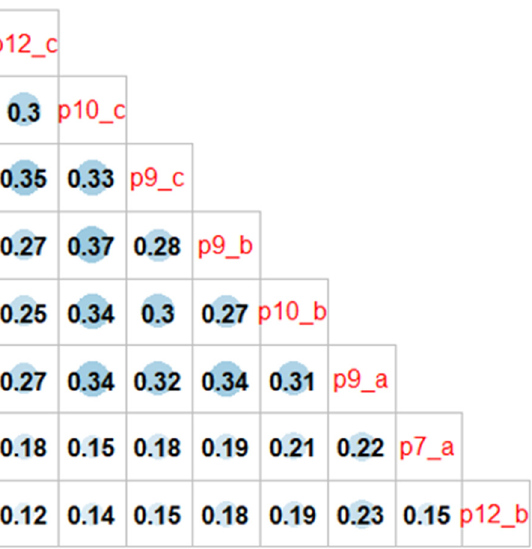
Figure 4. Correlation on the use of social science didactics to understand the process of socialization of students.